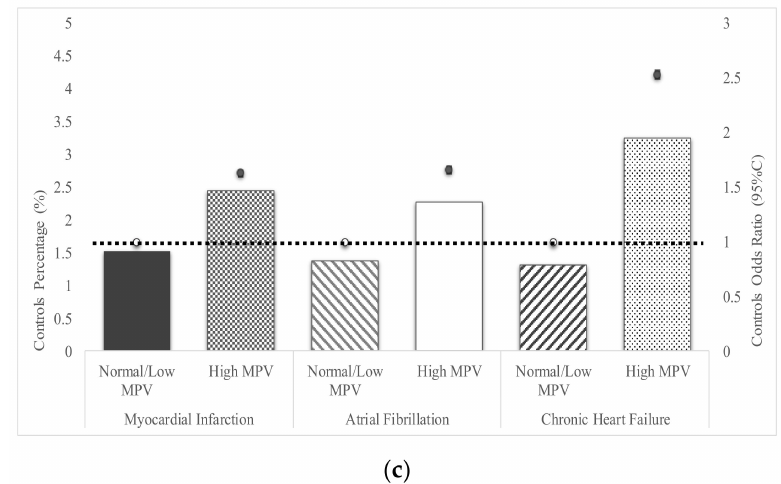
Figure 2. Development of Cardiovascular Disease based on high versus normal mean platelet volume (MPV) for Psoriasis patients, Psoriatic Arthritis patients, and Controls. The frequency and odds ratio of presenting with three distinct types of cardiovascular diseases based upon RDW status (high versus normal / low, as defined by Explorys) is shown for each group. The scale for the percentage of patients (PsO, PsA) or controls exhibiting each combination is demarcated on the left hand side of the graph, while the odds ratios (OR) scale is listed on the right hand side. Odds Ratios were adjusted for age, gender and hypertension. Open circles connected by the dashed line represent the reference value (1) for each OR. Odds Ratios are represented by solid circles and error bars, which represent 95% confidence intervals. The percentage of psoriasis patients ( a ), psoriatic arthritis patients ( b ) or control subjects ( c ) exhibiting either myocardial infarction (MI), atrial fibrillation (AF) and chronic heart failure in psoriasis patients based on MPV expression levels is shown. Prediction of odds ratio for development of the three types of heart failure in psoriasis ( a ) psoriatic arthritis ( b ) and controls ( c ) are quantified on the right